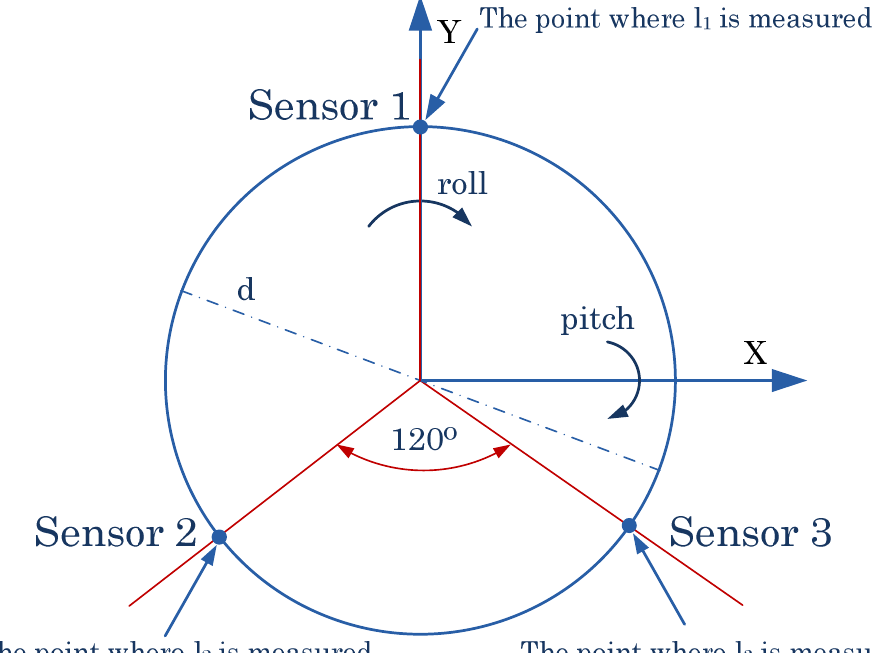
Figure 2. The position of the test-bench sensors in relation to the axis of the drone system.